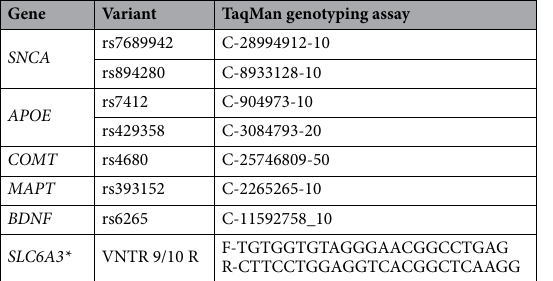
Table 5. The list of the TaqMan genotyping assays and the primers used for genotyping. * SLC6A3 VNTR was genotyped using custom made primers. For details please refer to